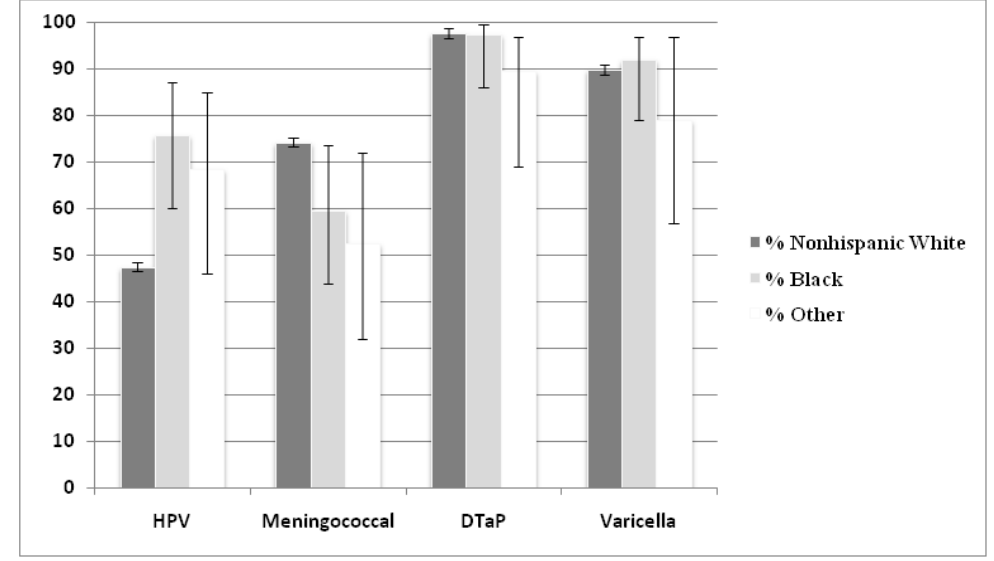
Figure 2. Vaccination rates of recommended adolescent vaccines by race.